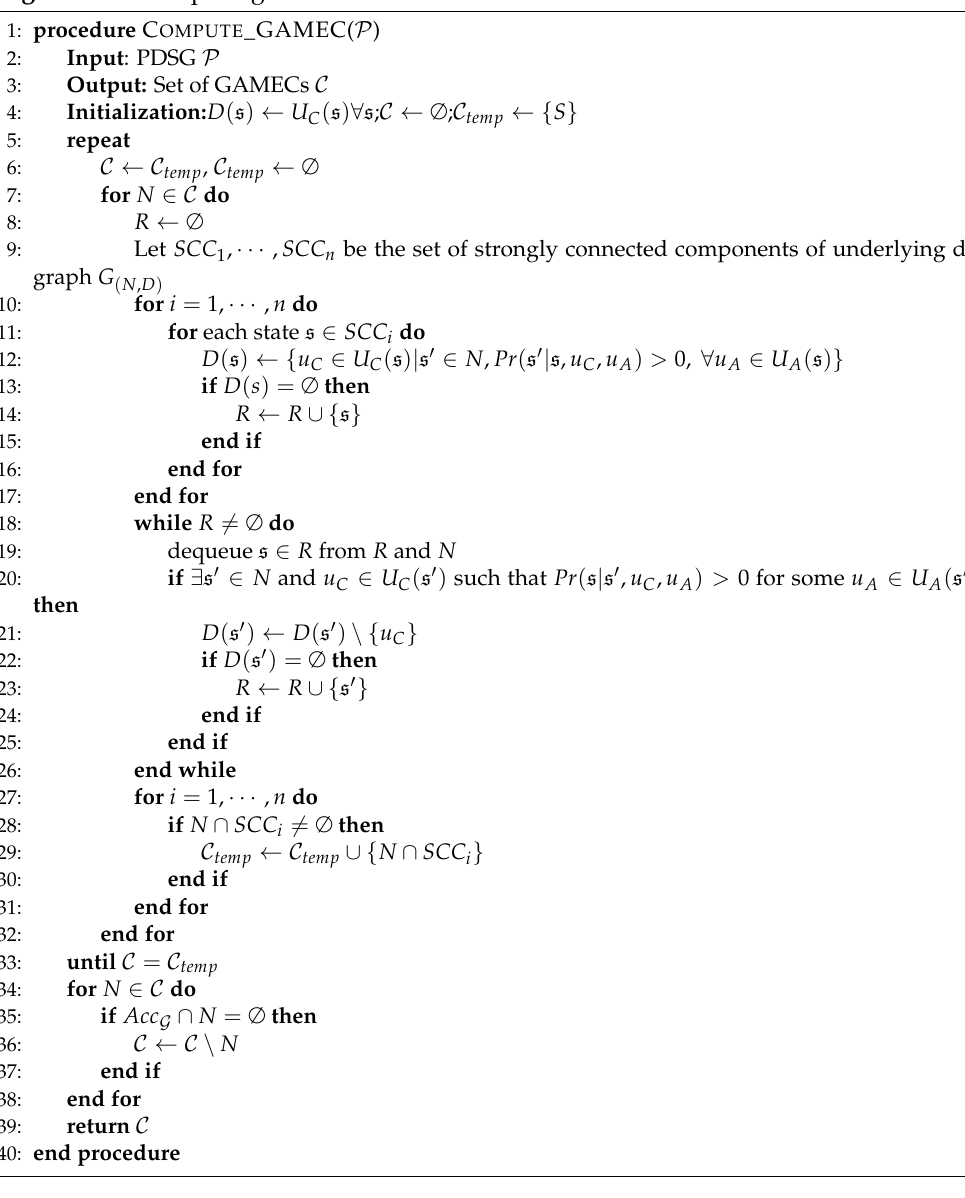
Algorithm 1 Computing the set of GAMECs C